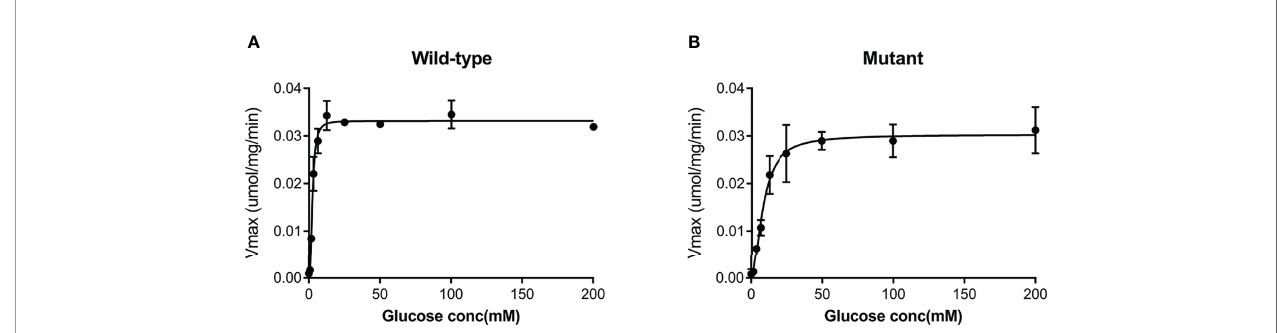
FIGURE 3 | Response curve of GCK for a series of glucose concentrations. (A) Wild-type GCK, (B) mutant GCK. The Ala259Thr mutation showed a lower maximum reaction velocity than the wild-type GCK, indicating a lower af fi nity for glucose.